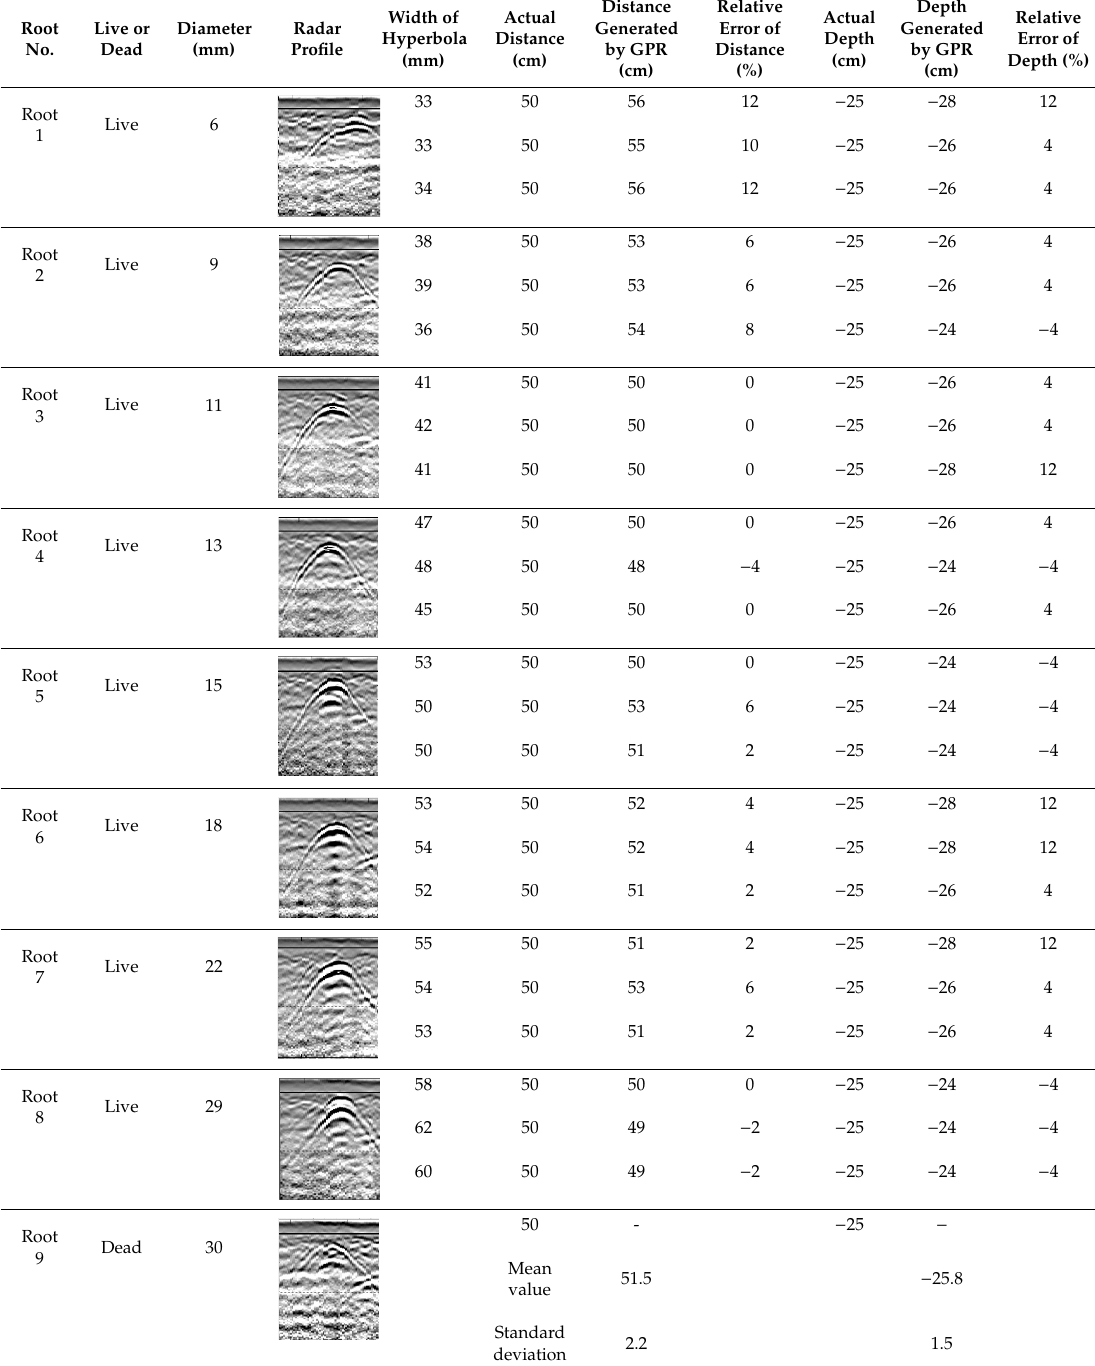
Table 1. Radar profiles of roots with different diameters and water content.